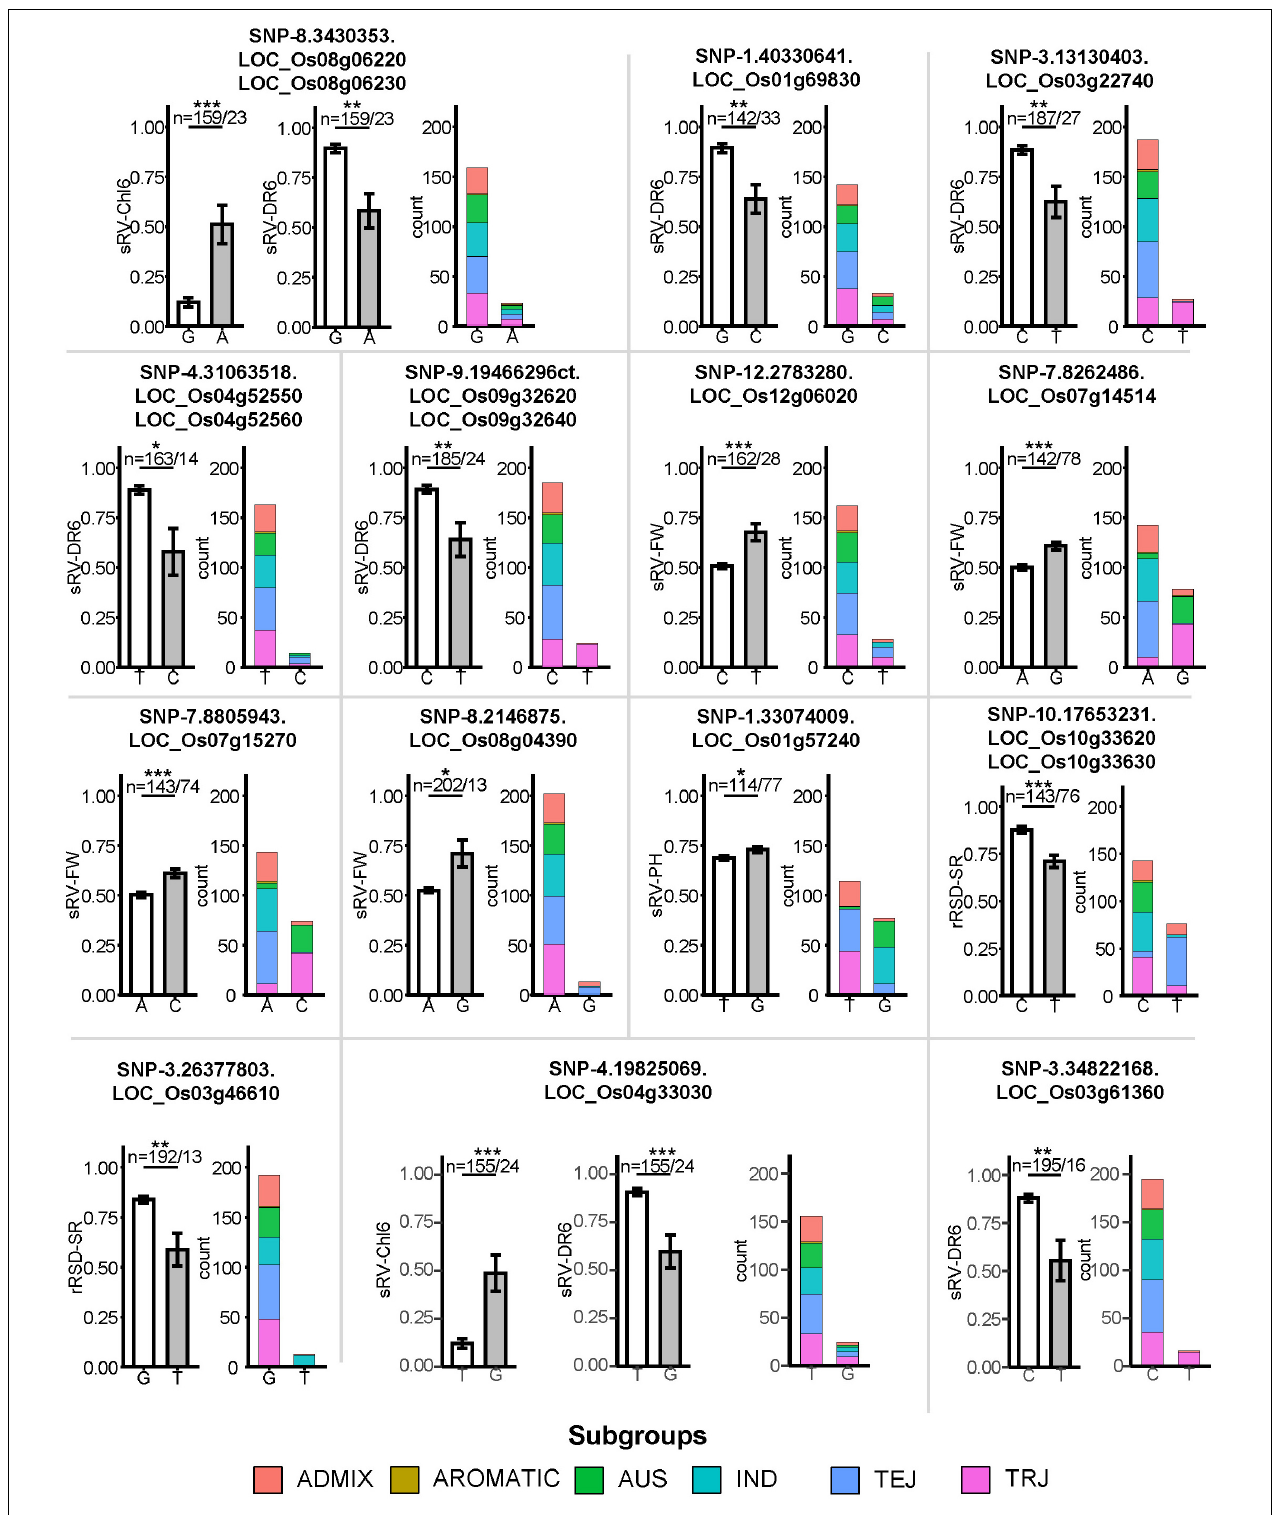
FIGURE 5 | Effects comparison of different haplotypes in 14 LFF SNPs associating with differentially expressed genes on salt tolerance. Error bars mean the standard errors. *, ** and *** indicate the difference reached statistically significant difference at the P value < 0.05, < 0.01, and < 0.001, respectively. Numbers of rice accessions contained different alleles in each SNP locus were listed on the top of columns. Two SNPs were found association with two ST indices.